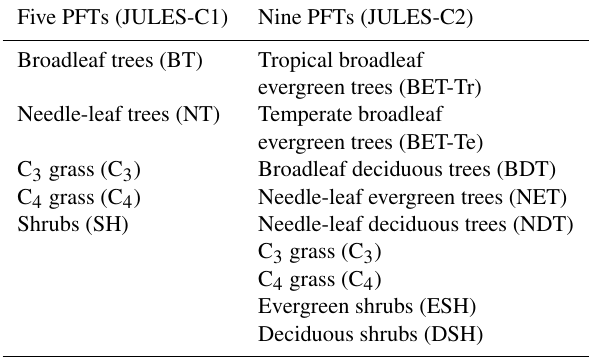
Table 1. The five original and nine new plant functional types (PFTs) in